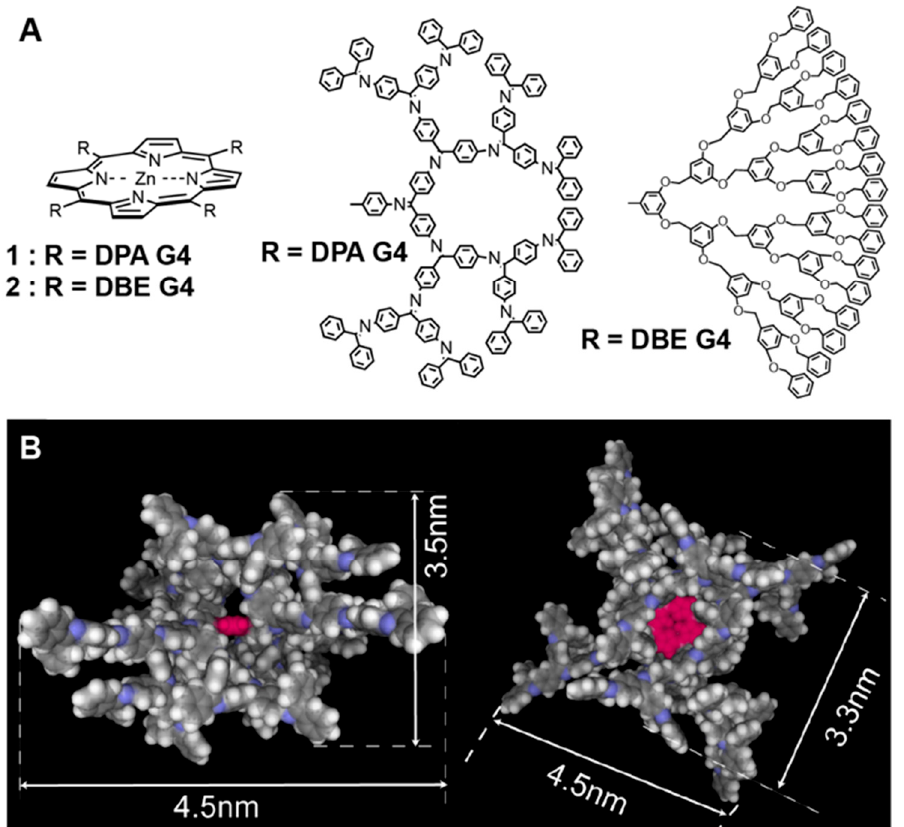
Figure 1. Structure of phenylazomethine dendrimer with a zinc porphyrin core ( 1 ). ( a ) Side view; ( b ) top view.